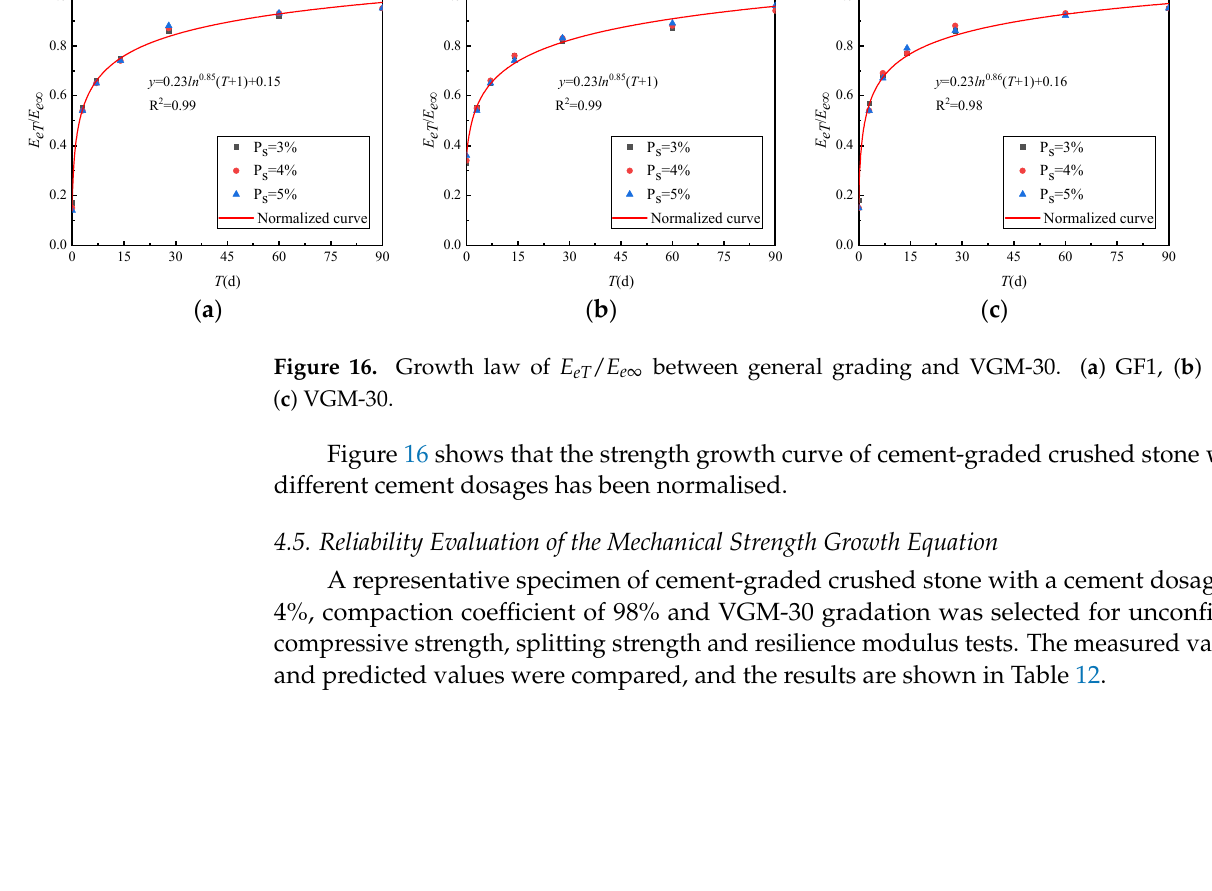
Table 12. The comparison of predicted and measured values.